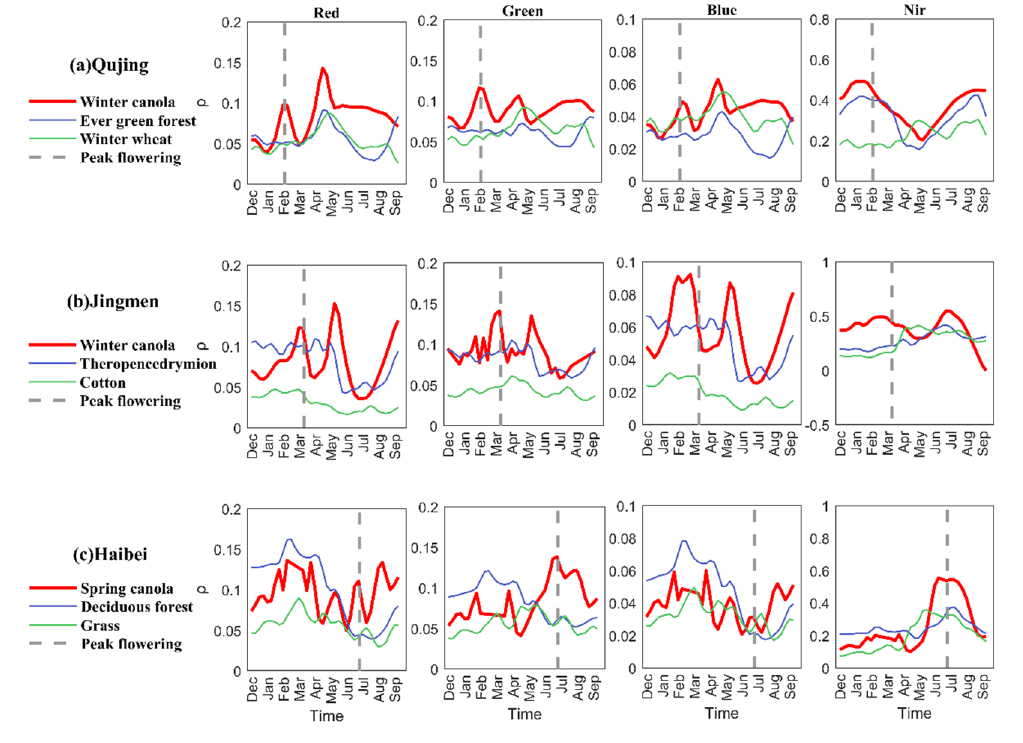
Figure 3. Time-series of Red, Green, Blue and Near infrared (Nir) bands and the actual flowering period of different land-cover types in different sites. ( a ) Qujing, ( b ) Jingmen, ( c ) Haibei.